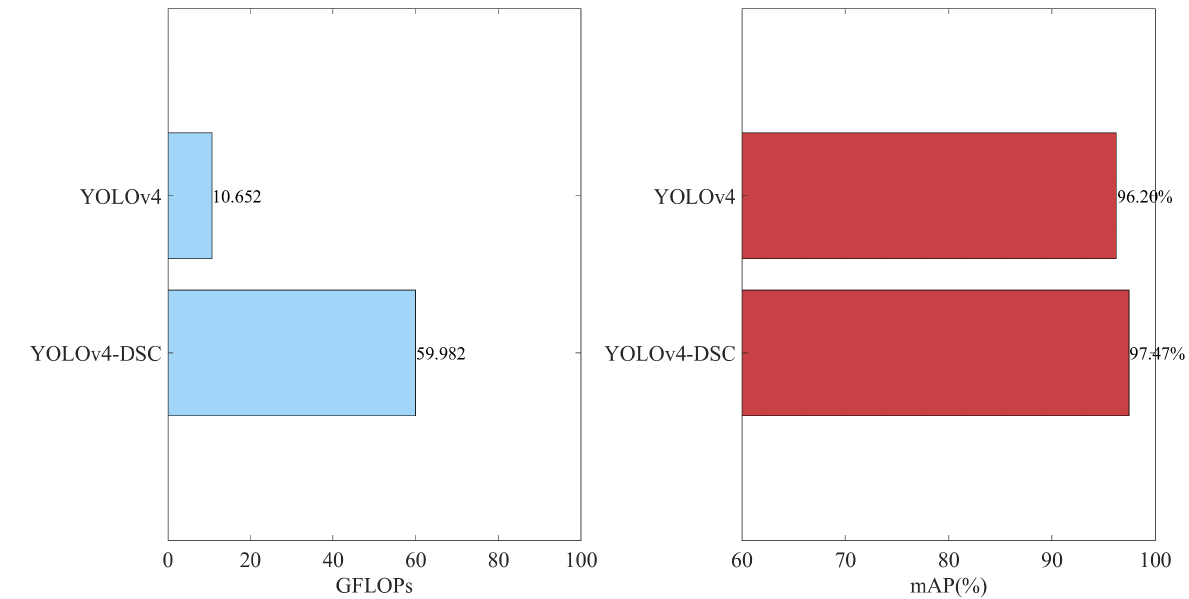
Figure 15. Comparison of YOLOv4 and